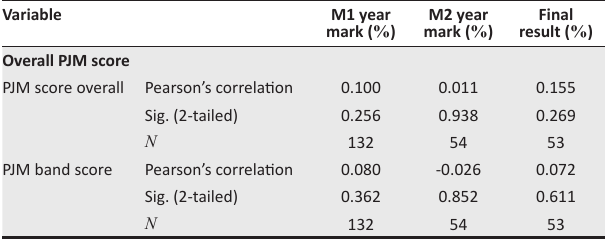
TABLE 2: Pearson’s correlation between the person job match overall score and band score and academic success. Variable